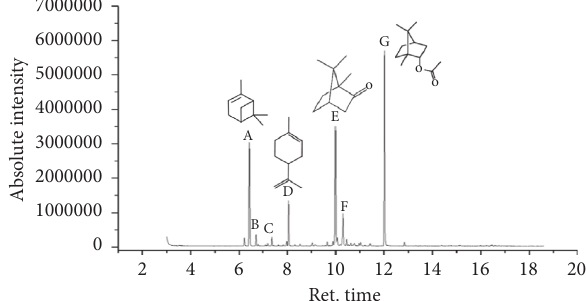
Figure 2: Chromatogram of the major components of Tetraclinis articulata essential oil ((A) α -pinene, (B) camphene, (C) α -thujone, (D) limonene, (E) camphor, (F) borneol, and (G) bornyl acetate).